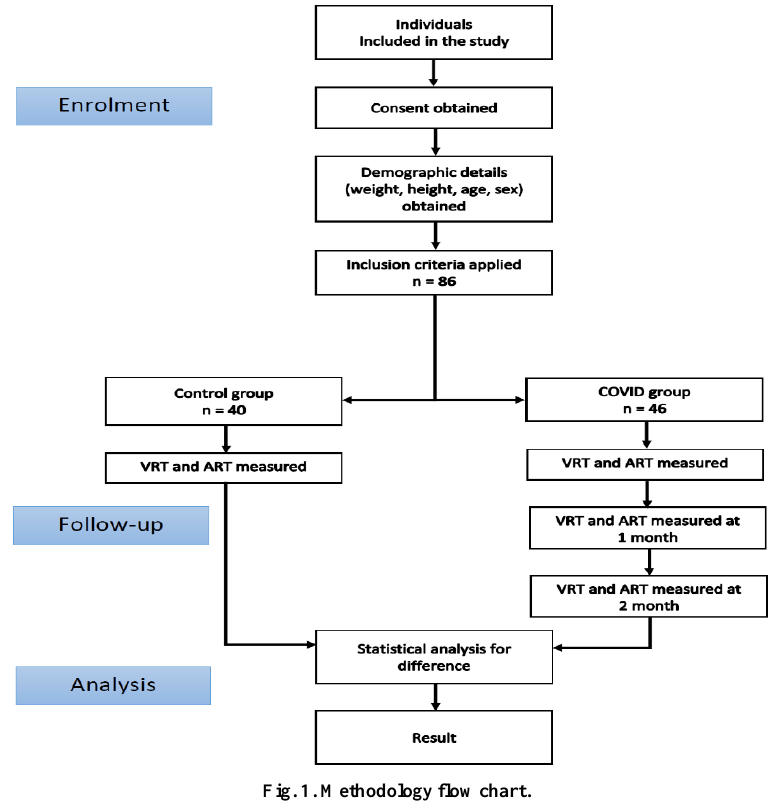
Fig. 1. Methodology flow